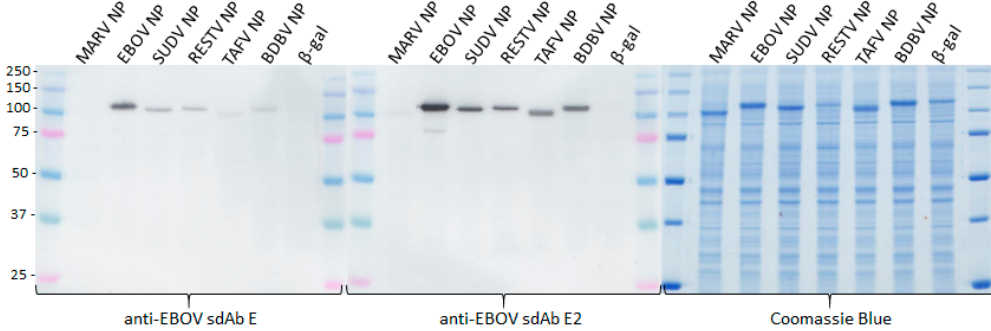
Figure 4. Western blotting of HEK293T cell lysates 24 h after transfecting plasmids encoding various NP genes or a control β -galactosidase gene. Blots were probed with 10 nM monomeric anti-EBOV sdAb–APEX2 or dimeric anti-EBOV sdAb–APEX2. Coomassie-stained gel of the equivalent sample loading was used for the blots. Gels were 10% SDS-PAGE and molecular weights of markers are indicated to the left in